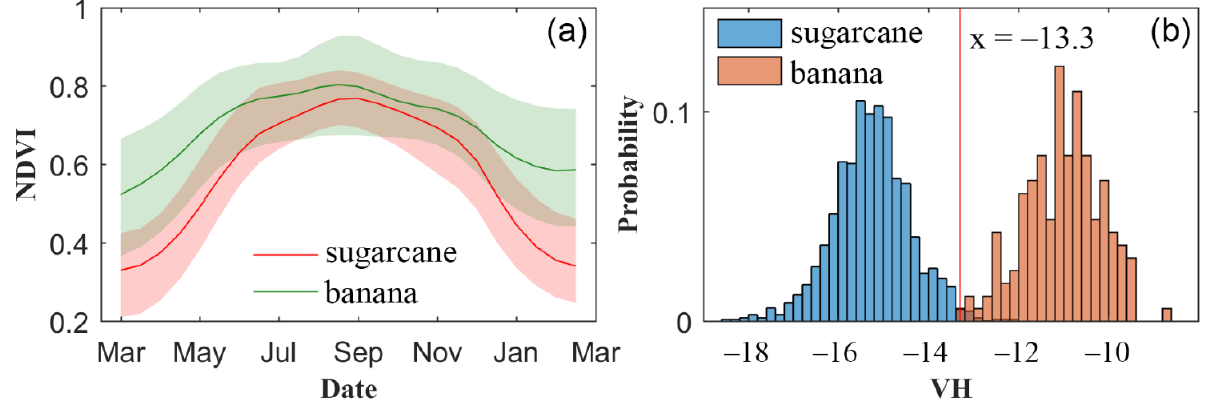
Figure 5. ( a ) Temporal patterns of the 16-day composite NDVI for sugarcane and banana (taking SR data as an example); ( b ) and distributions of averaged VH (vertical transmit/horizontal receive) polarization backscatter coefficient from June to November for sugarcane and banana.